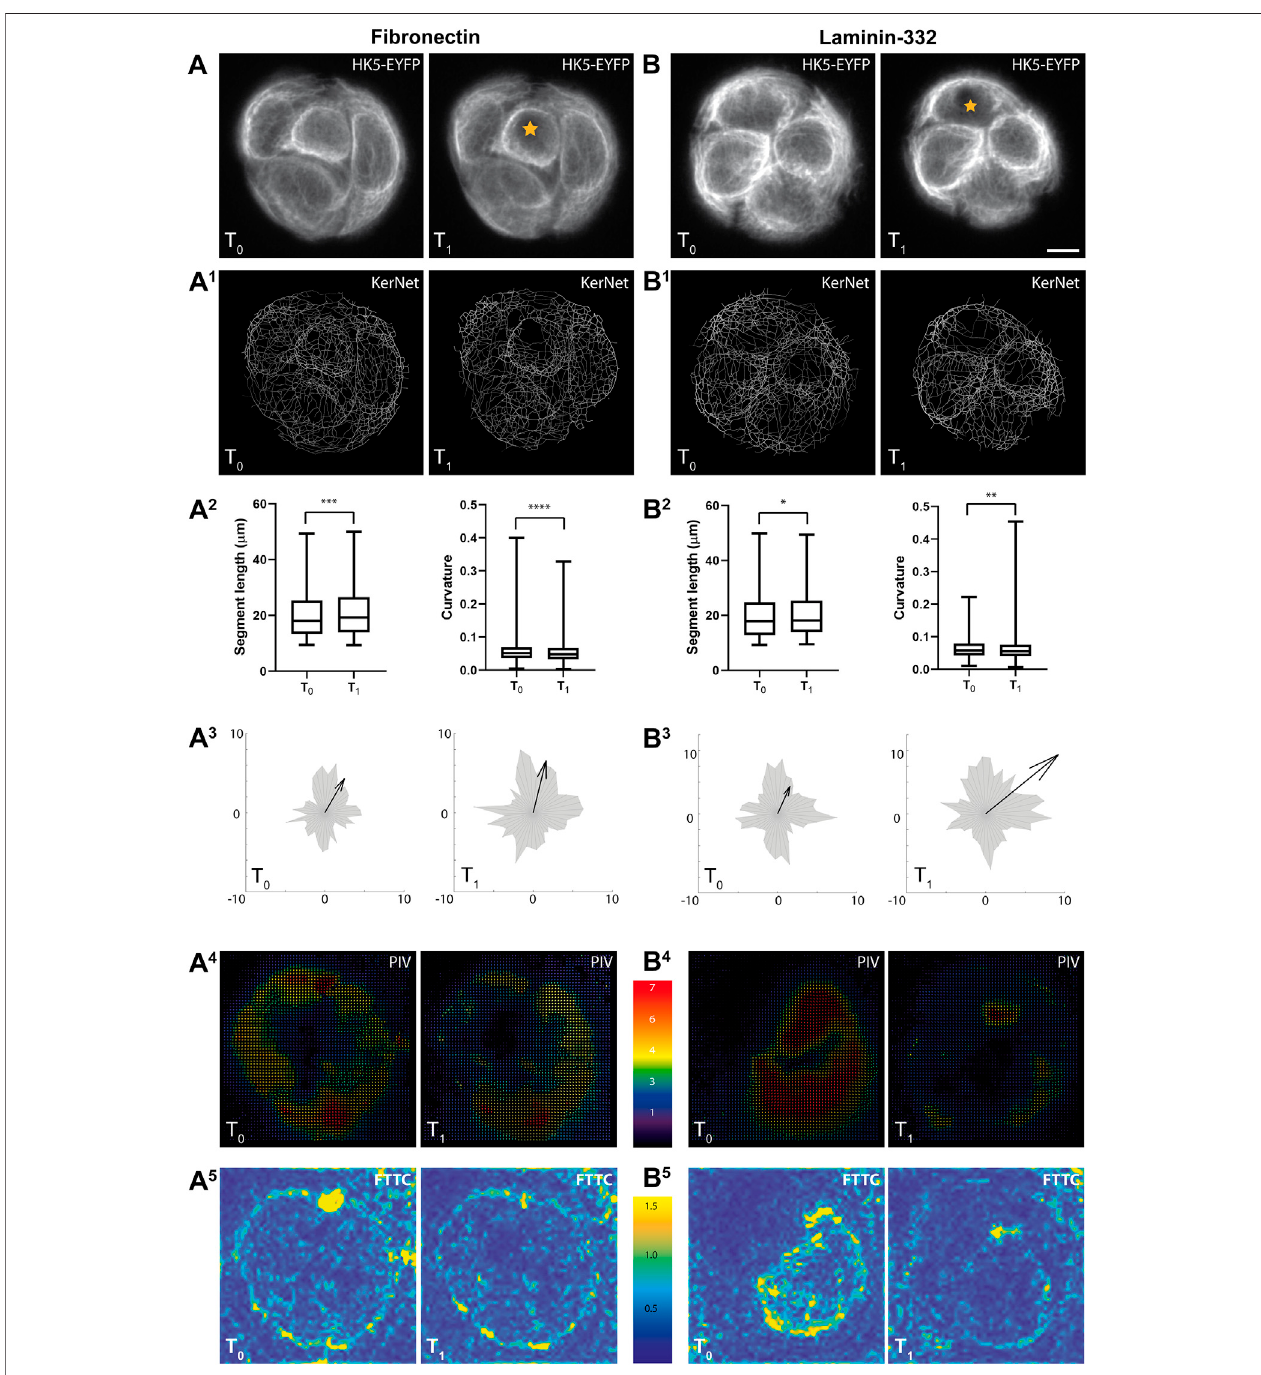
FIGURE5| Theimagesillustratecorrelatingrecordingsofchangingkeratinnetworkorganizationandtractionforcesinresponsetolocalcellablationandinrelation to ECM composition. Small groups of HaCaT cells were generated by using circular micropatterns with adiameter of 47 μ m. They were either coated with fi bronectin or laminin-332 as indicated. (A,B) Show pairs of image projections (20 slices/image) before (T 0 ) and 30 min after (T 1 ) photo-oxidation of a single cell (demarcated by star). Scale bar: 10 μ m (same magni fi cation in all images). (A 1 ,B 1 ) Present the resulting derived digital models of segmented KF networks. (A 2 ,B 2 ) Show histograms of segment lengths and curvatures. Note that both parameters are affected by the perturbation on either substrate. n = 1,561 segments ( fi bronectin), n = 1,740 segments (laminin-332);* p < 0.05, ** p < 0.01,*** p < 0.001,**** p < 0.0001. (A 3 ,B 3 ) Presentdiagramsofsegmentorientationsasradialhistograms. Vectors arearrangedinrelation to the center of the micropattern. The arrow represents the sum of all vectors including direction and magnitude. Note that the direction and magnitude of the sum vectorsareonly mildlyaffectedbythephoto-oxidation. (A 4 ,B 4 ) Presentthedisplacementvectorsofthe fi ducialbeadsembeddedintheelasticsubstrateunderneath the micropattern.ThevectorswerecalculatedbyPIV. (A 5 ,B 5 ) ShowthemagnitudeofthePIVvaluesinkParepresentingthetractionforces(FTTC).Notetheoverallreduction in traction forces with only minor changes in overall distribution. Scale bar: 10 μ m.